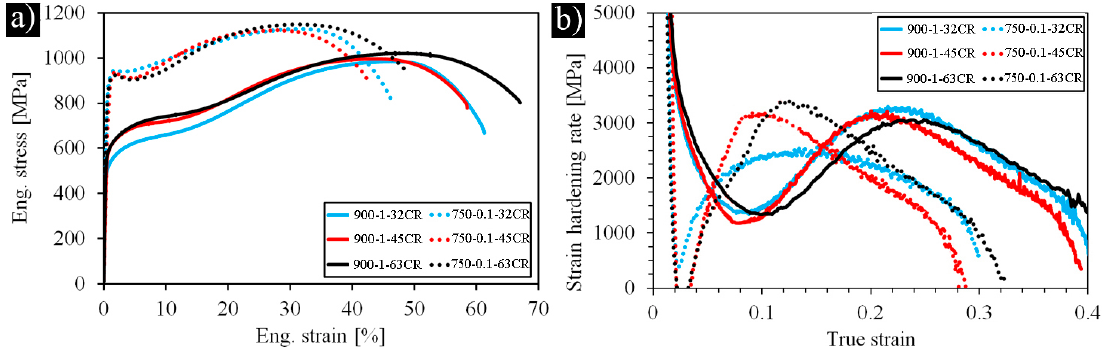
Figure 8. Engineering stress-strain curves ( a ) and strain hardening curves ( b ) for the structures. Table 3. Tensile test properties of the studied structures.